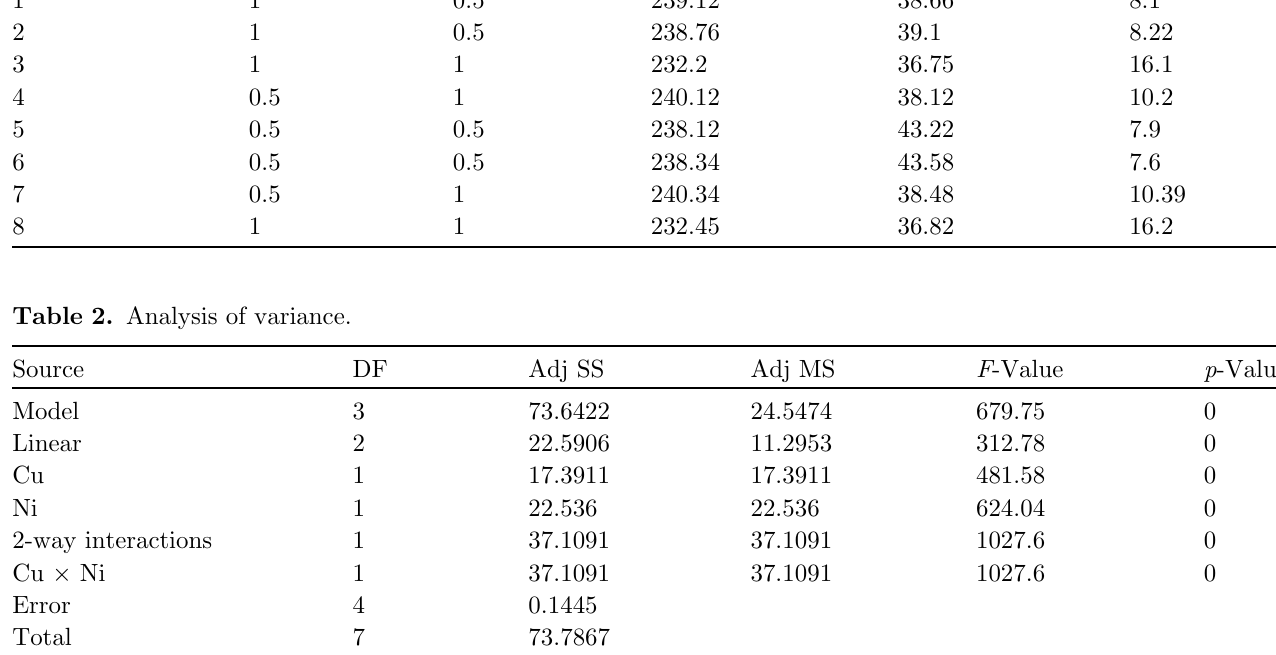
Table 1. Output from the 8 runs conducted. Experiment Runs Cu (% by wt.)